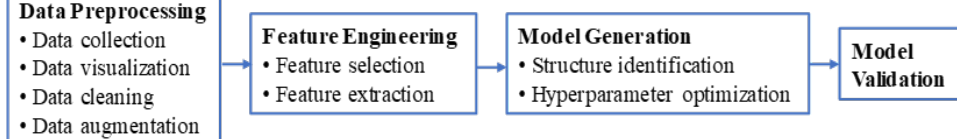
Figure 1. The typical pipeline of an AutoML approach involves four basic stages: data preprocessing, feature engineering, model generation, and model validation (each one of the above stages involve several tasks, where a subset of these tasks is developed and implemented in a specific application).